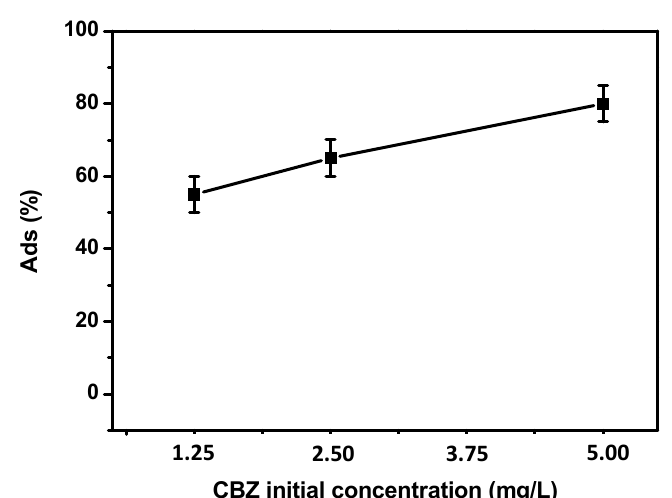
Figure 3. Dependence of the CBZ maximum adsorption percentage on CBZ concentration.